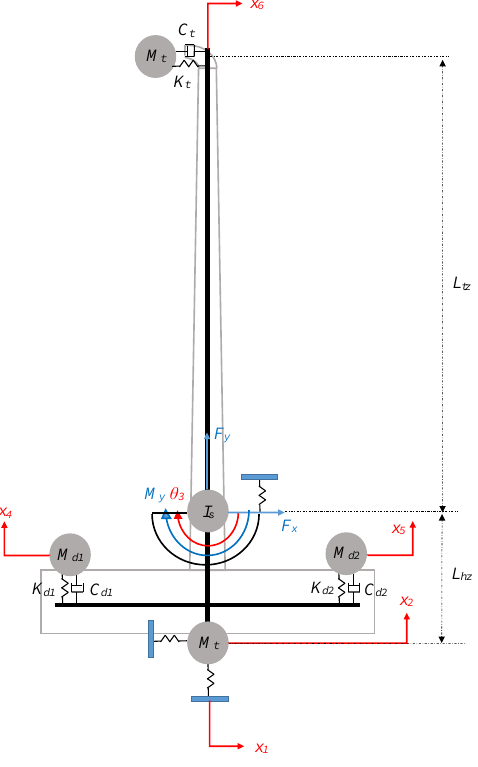
Figure 8. A diagram of the FDF model